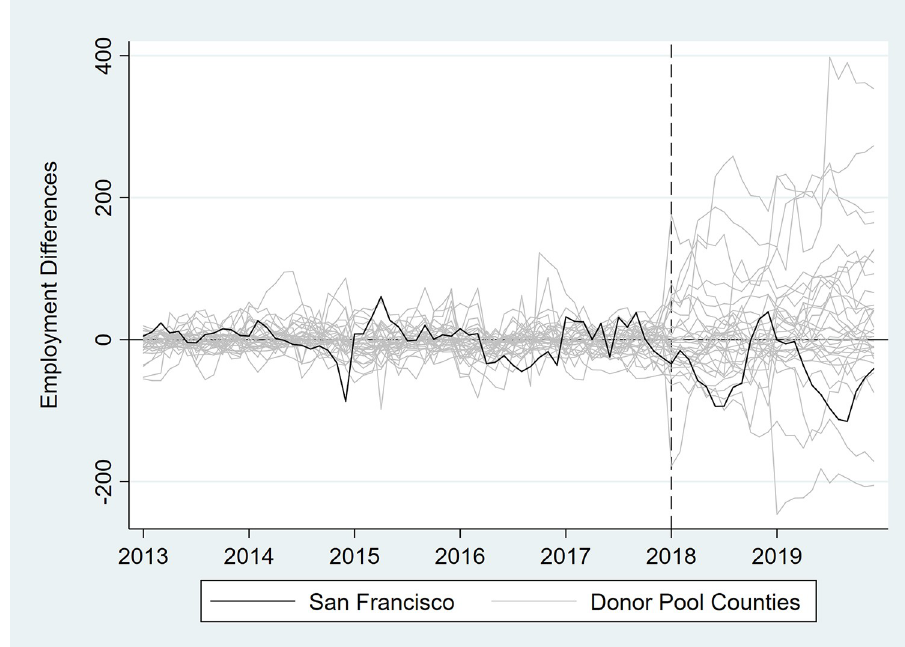
Fig 12. Differences in employment outcomes between each county and its synthetic control for beverage manufacturing